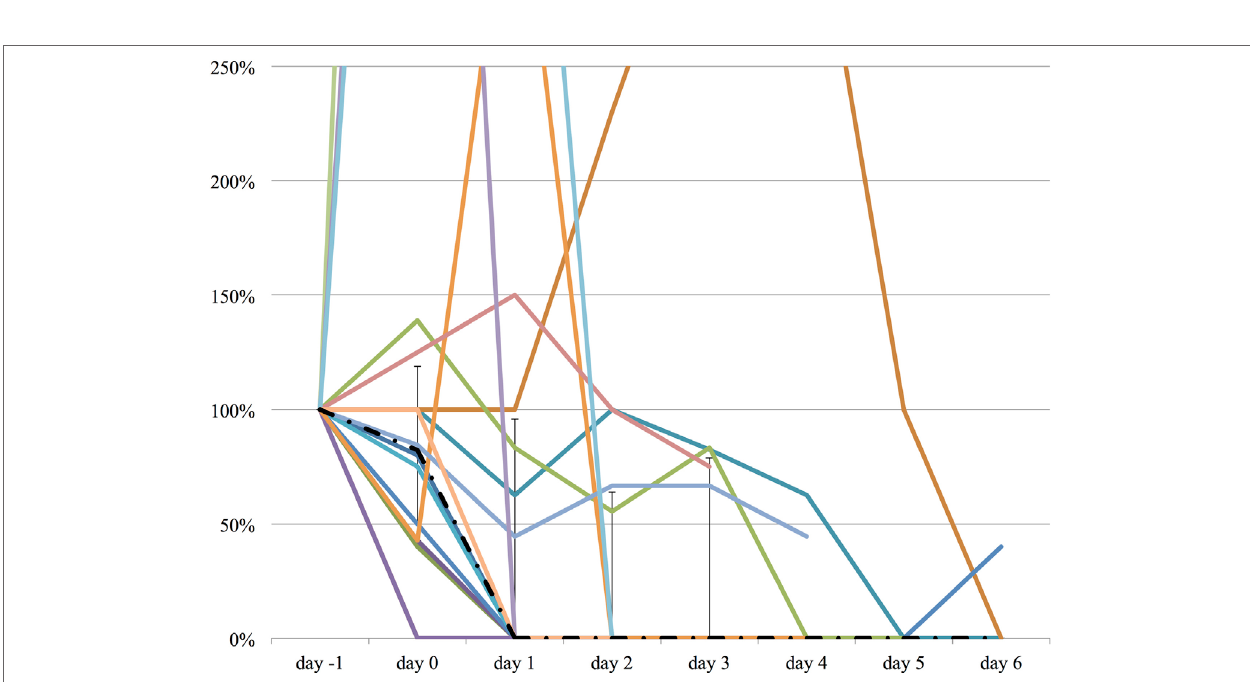
FigUrE 5 | The relative change in haloperidol dose from day − 1 to day 6 . The vertical axis represents percent change of haloperidol dose of each patient, compared to day − 1. The dashed line represents the median haloperidol dose, and the range represents the interquartile